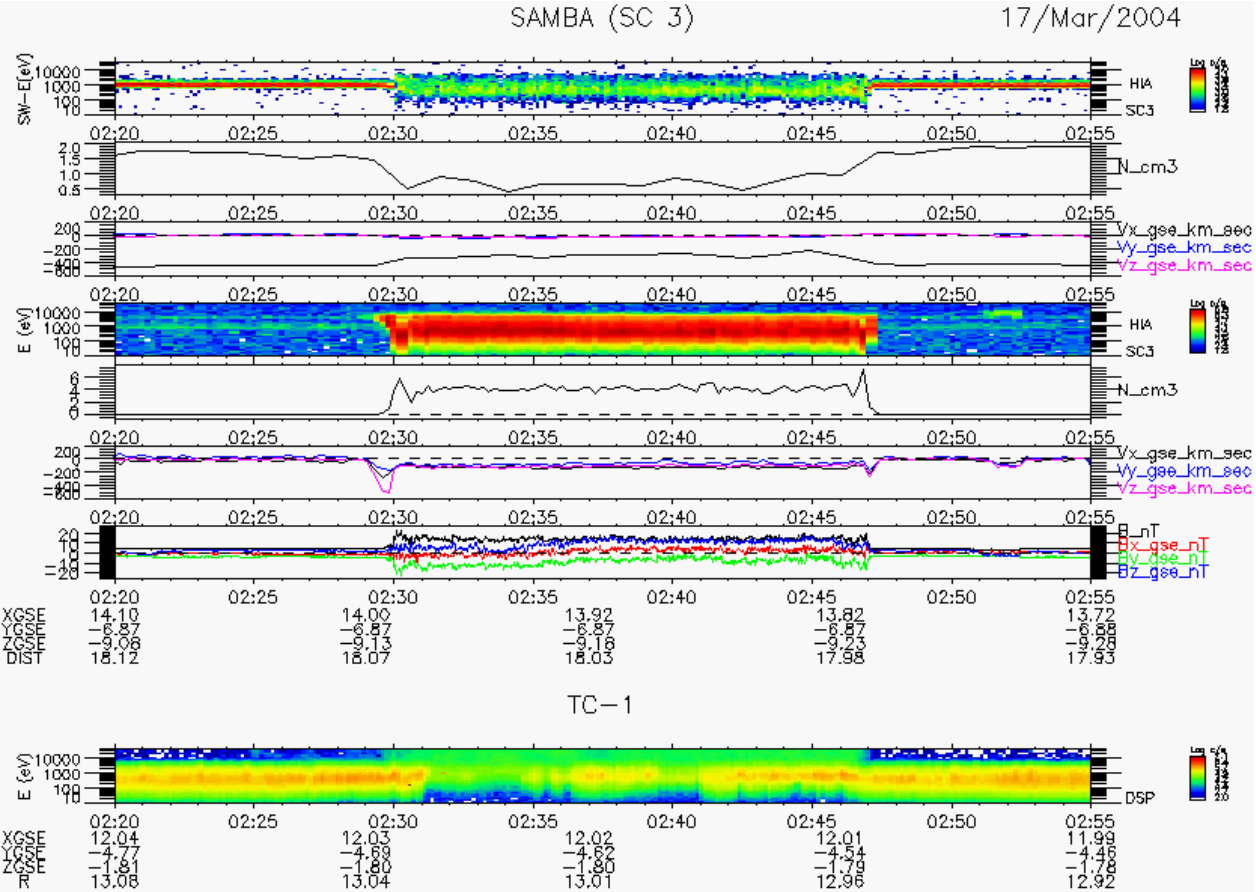
Fig. 3. Magnetic field and hot ion parameters from Cluster C3 . From top, (a–c) time-energy spectrogram and density and velocities of solar wind particles respectively, (d–f) time-energy spectrogram and density and velocities of magnetosheath particles respectively. g) components of magnetic field. However, the last panel is hot ion time-energy spectrogram from